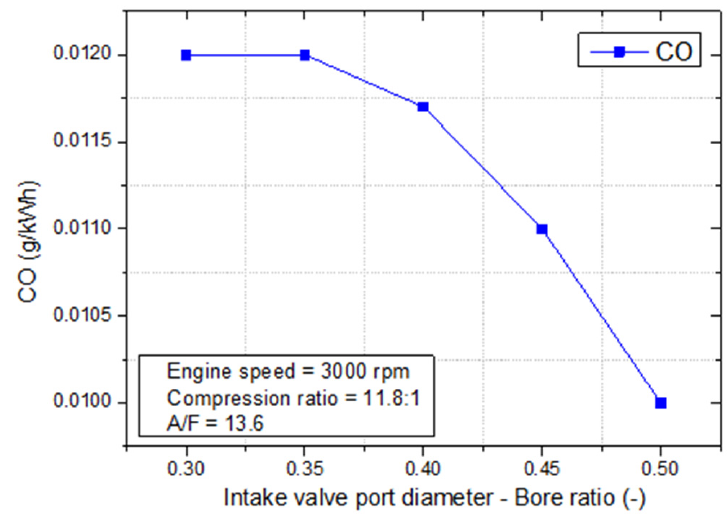
Figure 14. HC trend versus IPD/B.